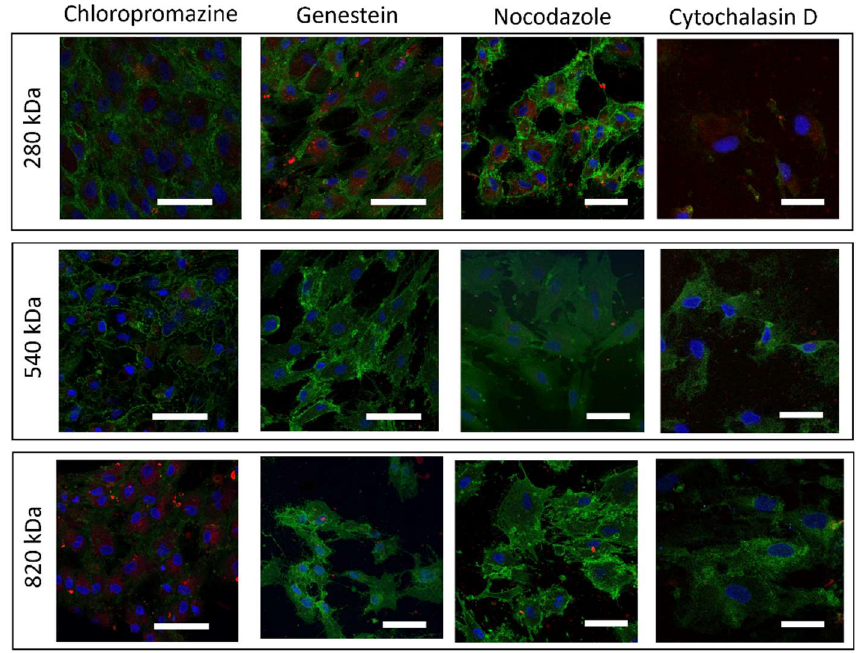
Figure 8. Confocal microscopy images of hMSCs after exposure to each one of the inhibitors (Chlor- promazine, Genistein, Nocodazole, Cytochalasin D) for 30 min and then exposed to HA/CS NPs (280, 540 and 820 kDa HA) for 90 min (scale bar = 50 µm).